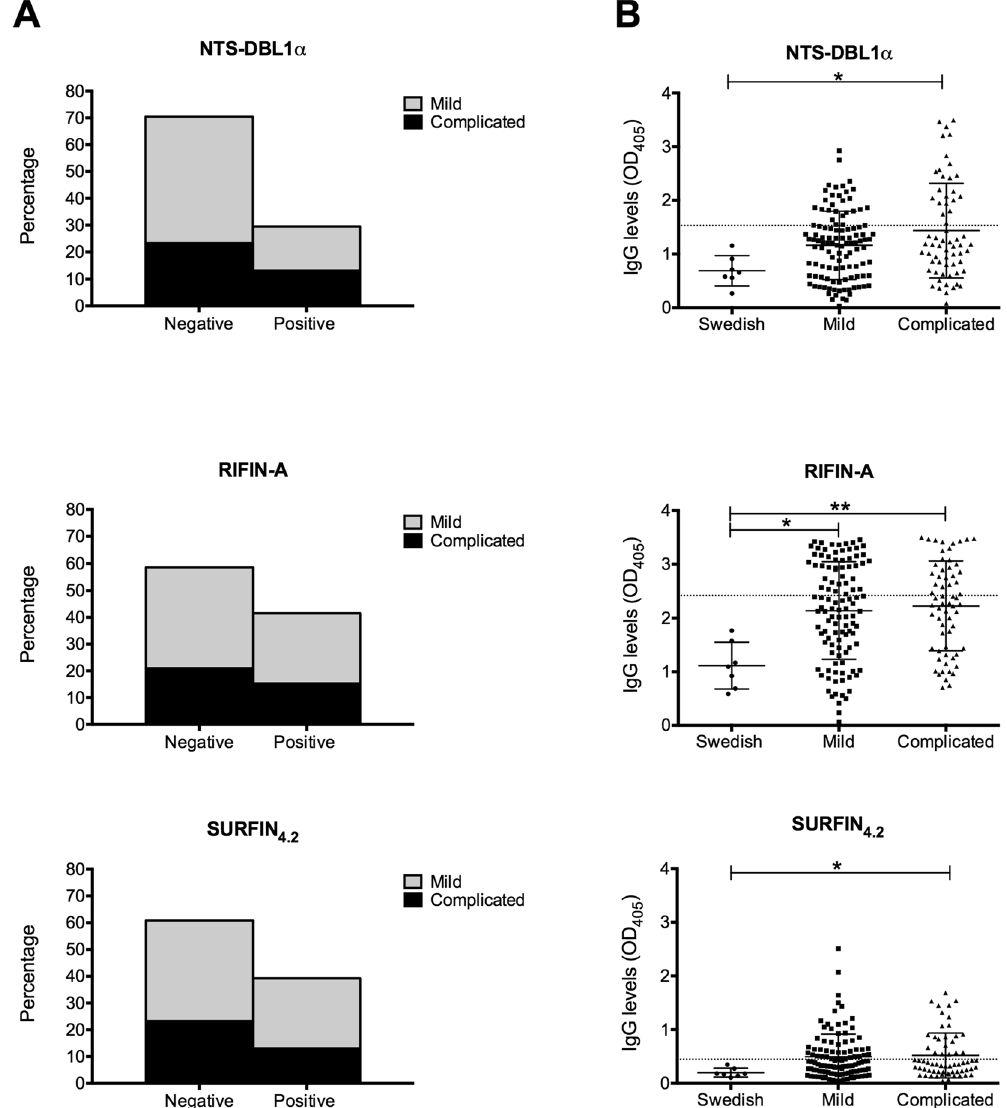
Figure 1. IgG levels against the NTS-DBL1 α , RIFIN-A and SURFIN 4.2 . ( A ) Antibody seroprevalence in children with mild and complicated malaria against three surface proteins. ( B ) IgG levels compared between children with mild/complicated malaria and Swedish adults controls. Scatter dot plots show the means and SD. Differences between the groups were determined using a Kruskal-Wallis test. The dotted lines on each graph represent the threshold above which samples were considered as positive